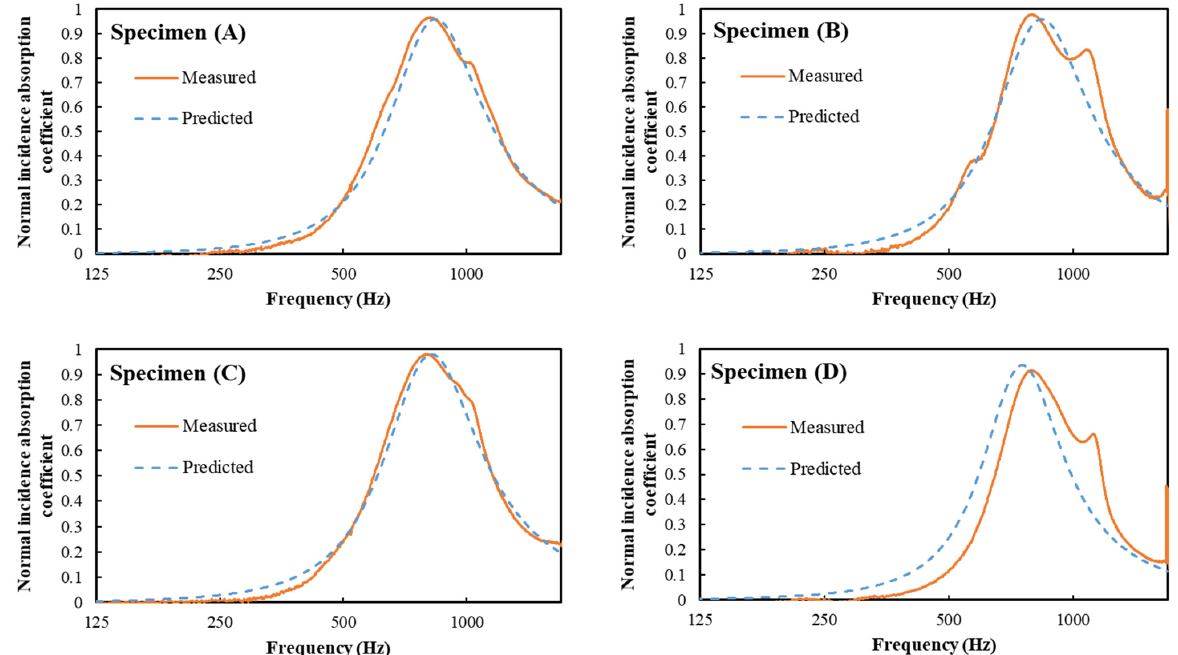
Figure 9. Measured results for the normal incidence absorption coefficient and their comparison with predicted values when the air cavity is 25 mm. Solid line: Measured; dashed line: Predicted. The parameters of Specimens (A), (B), (C) and (D) are detailed in Table 1 and Figures 1–4.